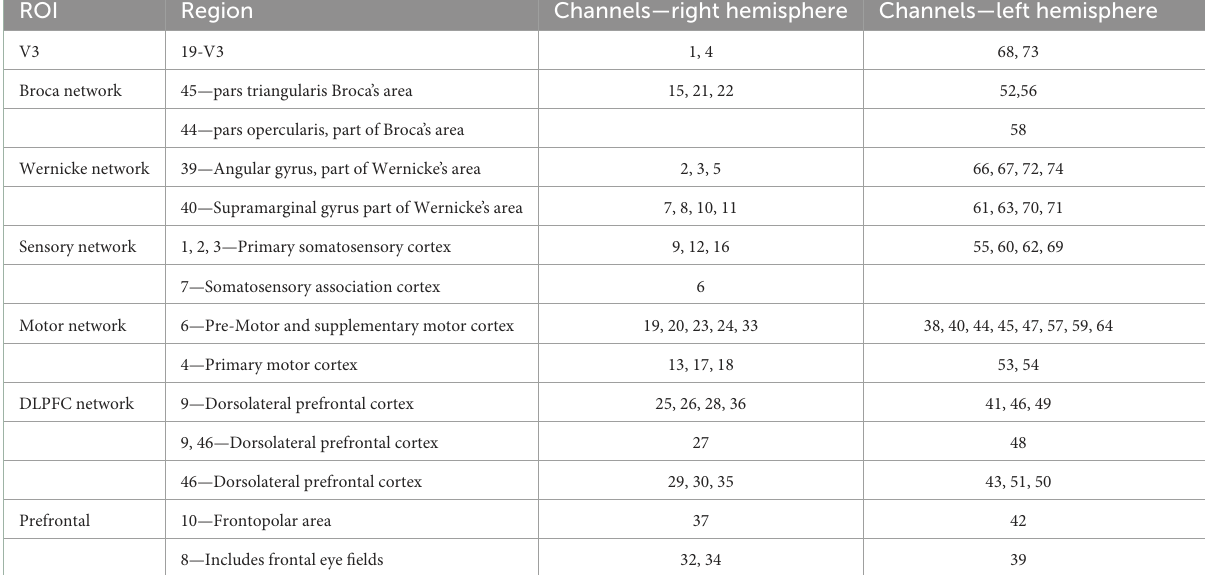
TABLE 1 The brain representative area with a most percentage on a Brodmann template under each channel (74 channels). ROI Region Channels—right hemisphere Channels—left hemisphere V3 19-V3 1, 4 68, 73 Broca network 45—pars triangularis Broca’s area 15, 21, 22 52,56 44—pars opercularis, part of Broca’s